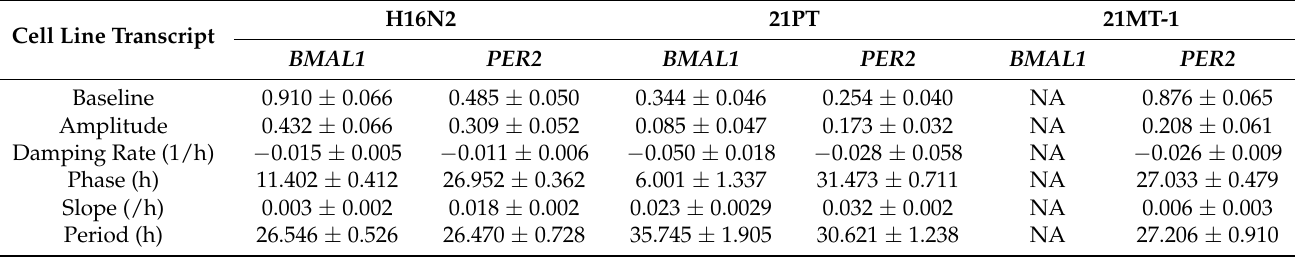
Table 1. Circadian parameters for BMAL1 and PER2